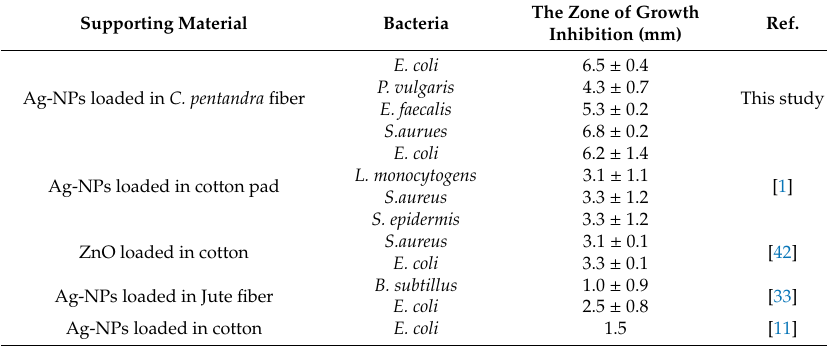
Table 2. The comparison on the performance of antibacterial activities based on the zone of growth inhibition by C. pentandra / Ag-NPs with other Ag-NPs loaded in supporting materials reported in the literature.